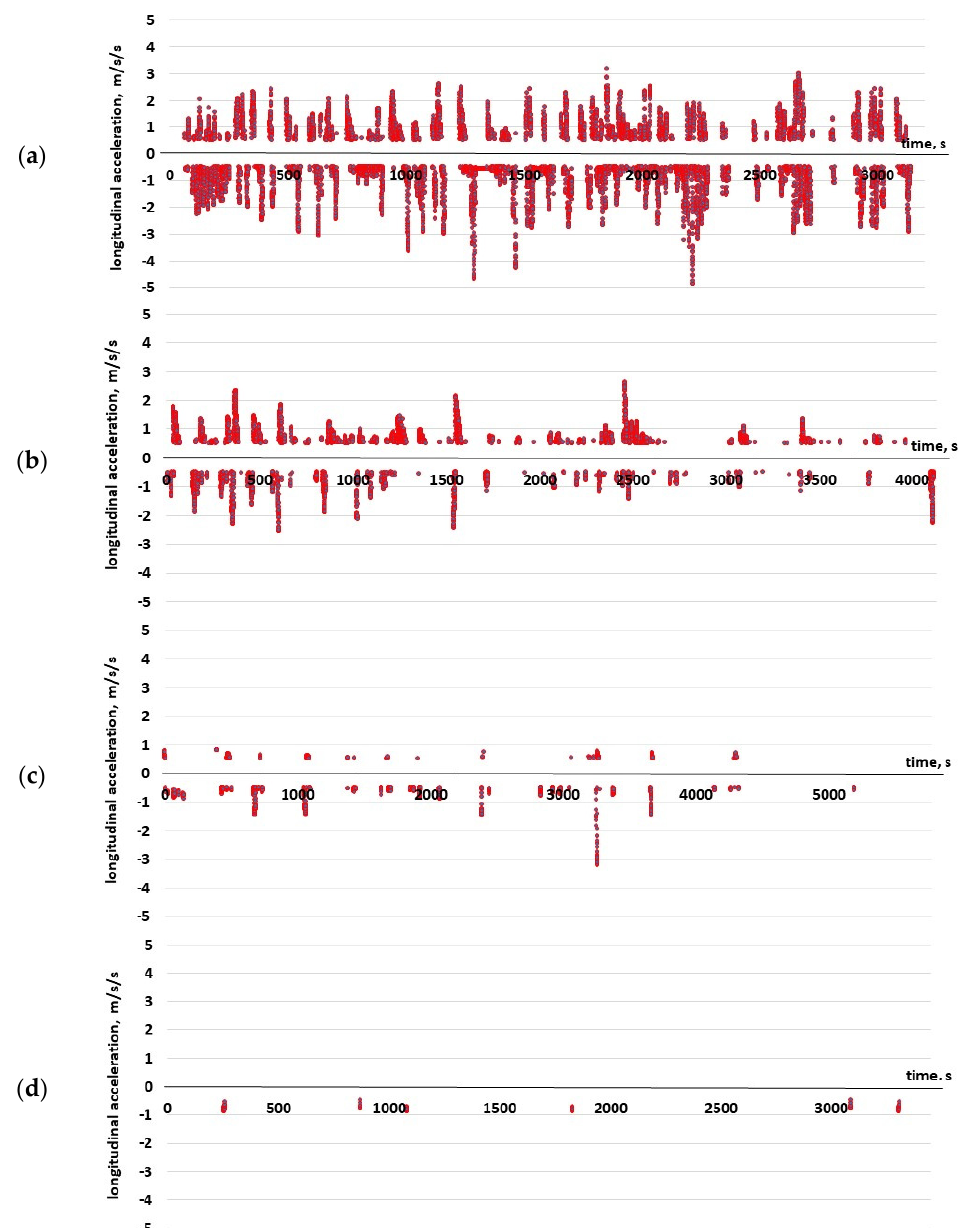
Figure 8. Longitudinal acceleration values excluding the ‘constant speed’ driving range on various road types: ( a ) urban area (city); ( b ) non-urban area (single roadway with two traffic lanes); ( c ) two- roadway expressway; ( d )